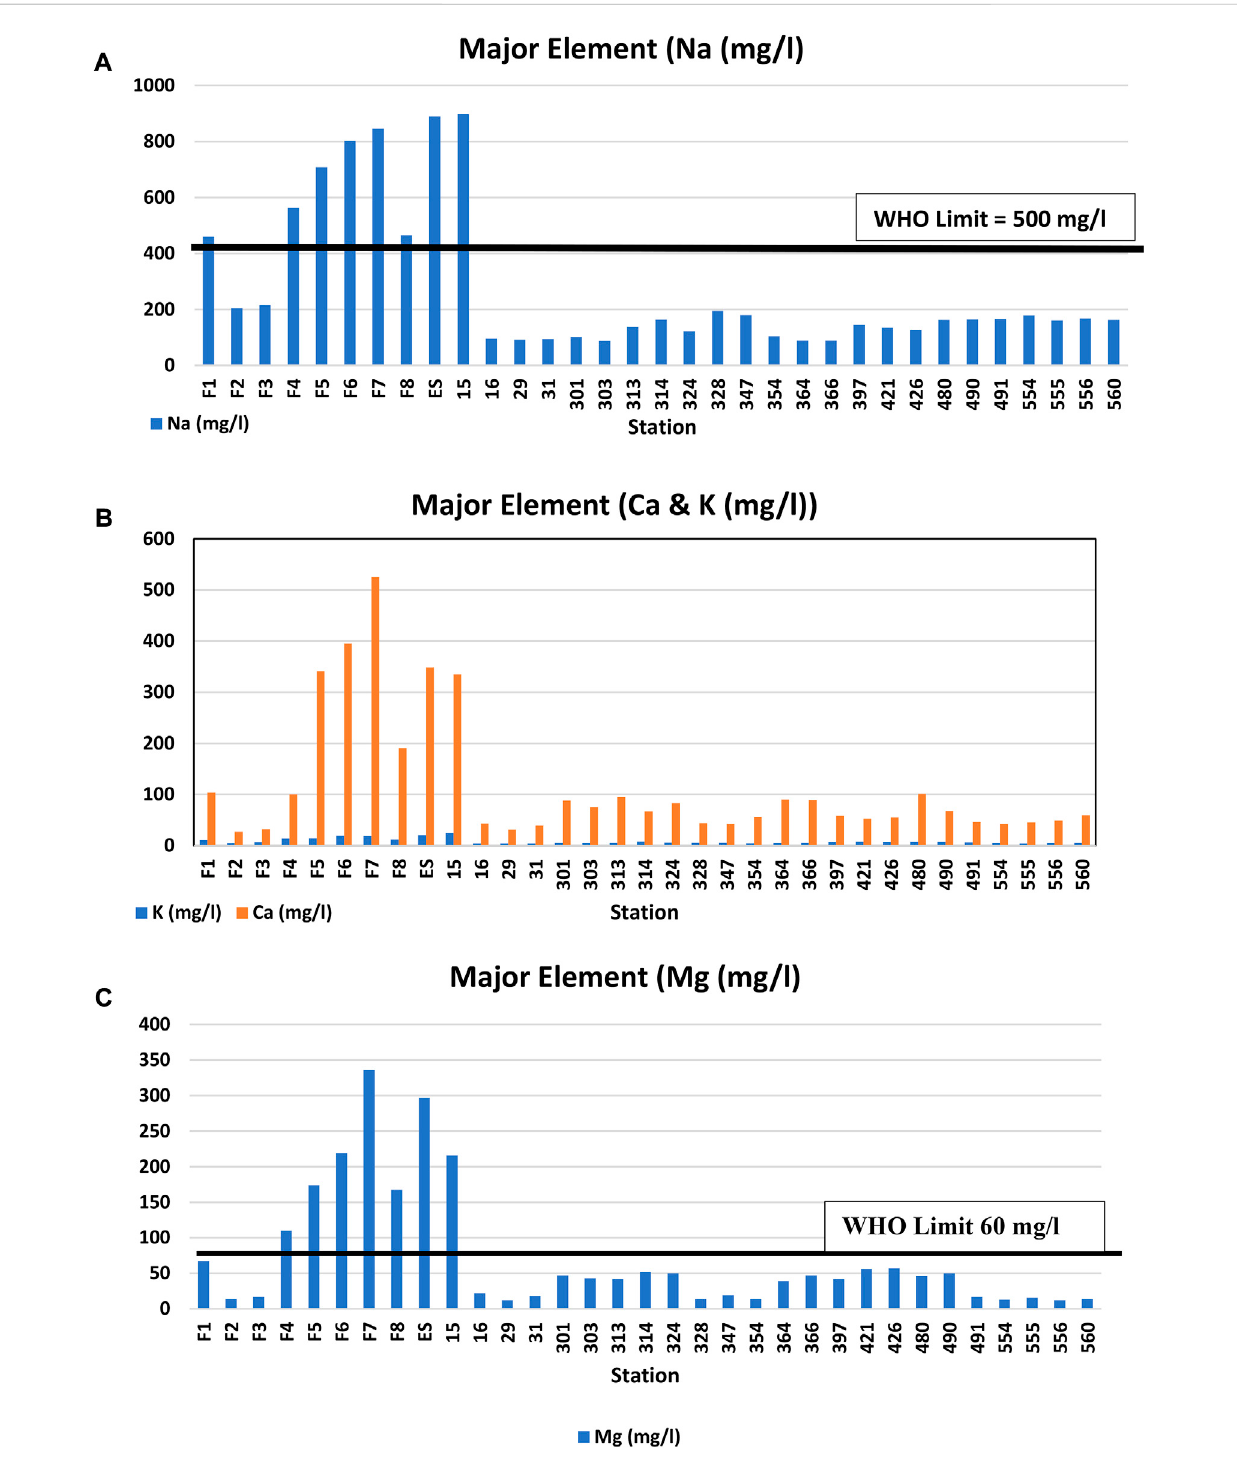
FIGURE 4 (A) Sodium concentration in a water sample with their WHO limit 500 mg/L. (B) Calcium and potassium concentrations in water sample of Rahat Volcanic Field. (C) Magnesium concentrations in water sample of Rahat Volcanic